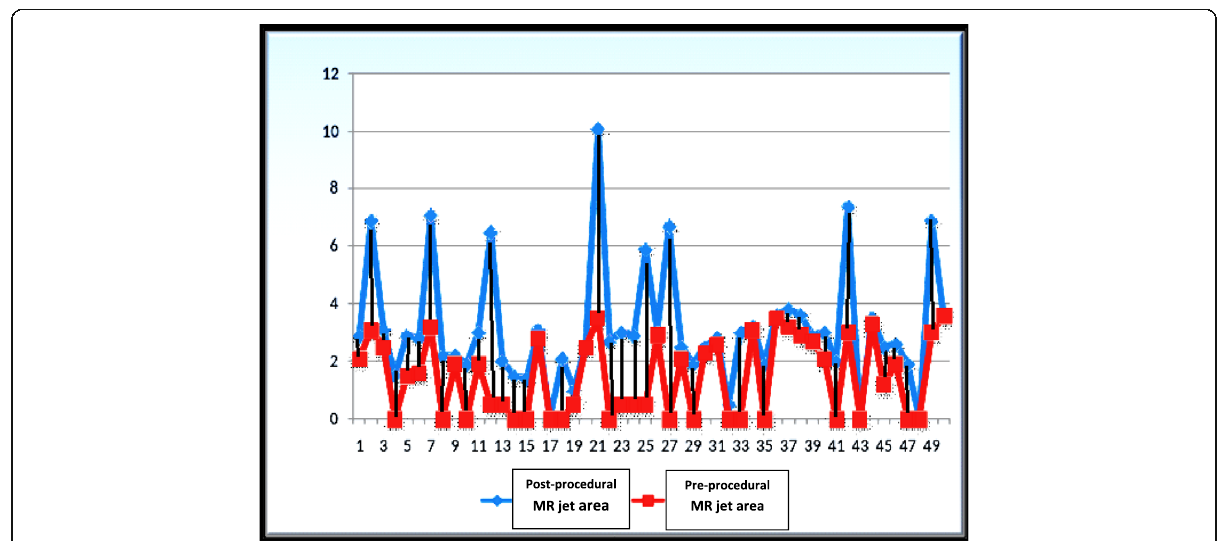
Fig. 1 Change in mitral regurgitation jet area before and after percutaneous balloon mitral valvuloplasty in each